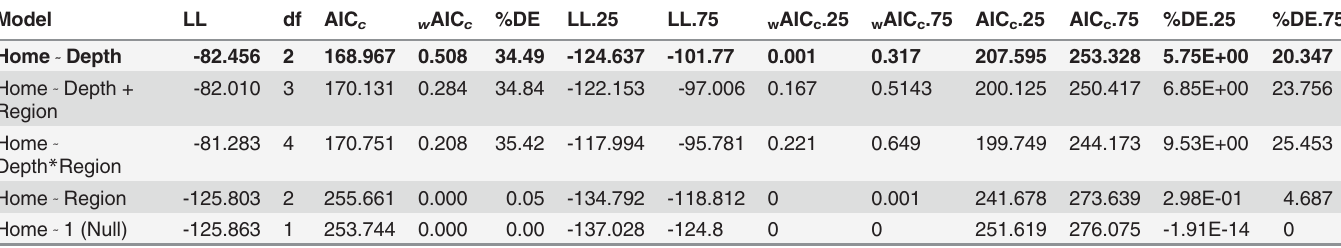
Table 2. Ranked Generalised Linear Models with bootstrap sampling of the probability of a shark being in a 25% utilisation distribution explained by bathymetry (Depth) and region of the coast (Region).